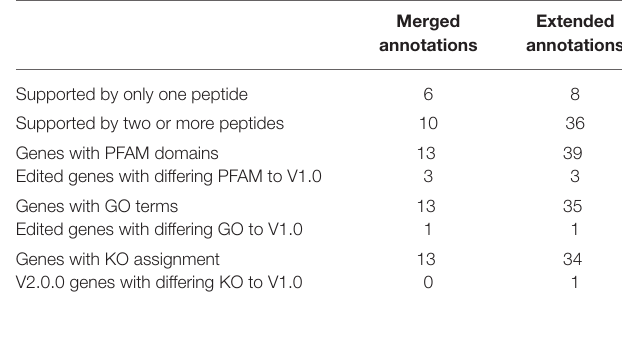
TABLE 6 | Summary of new gene validation using supporting peptides, PFAM, and Gene Ontology terms using Protein Pilot.